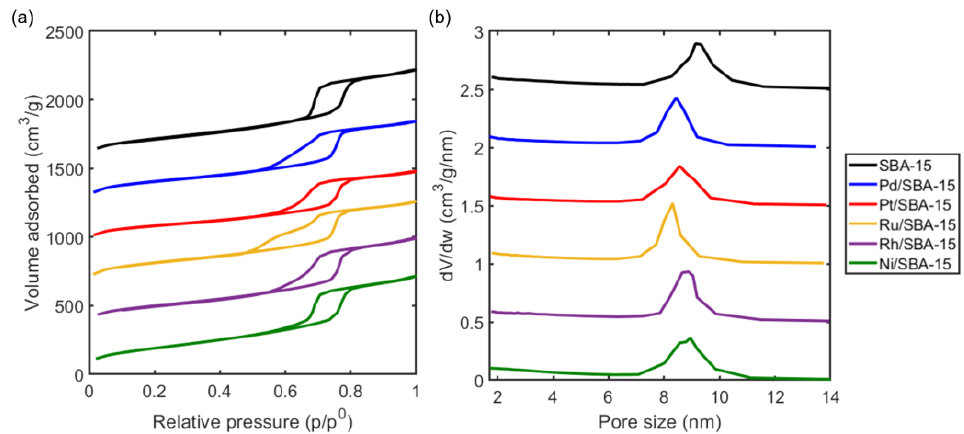
Figure 5. ( a ) N 2 adsorption–desorption isotherms and ( b ) pore size distributions of the SBA-15, Pd/SBA-15, Pt/SBA-15, Ru/SBA-15, Rh/SBA-15, and Ni/SBA-15.